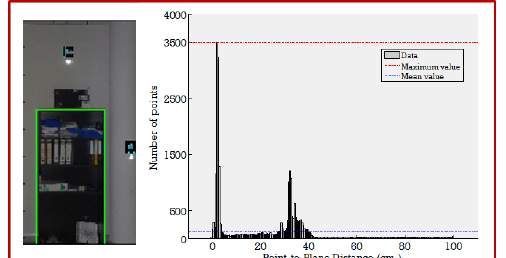
Figure 9. Histogram of point-to-plane distances: a bookshelf is detected as false-positive door and labeled as NON-DOOR object.